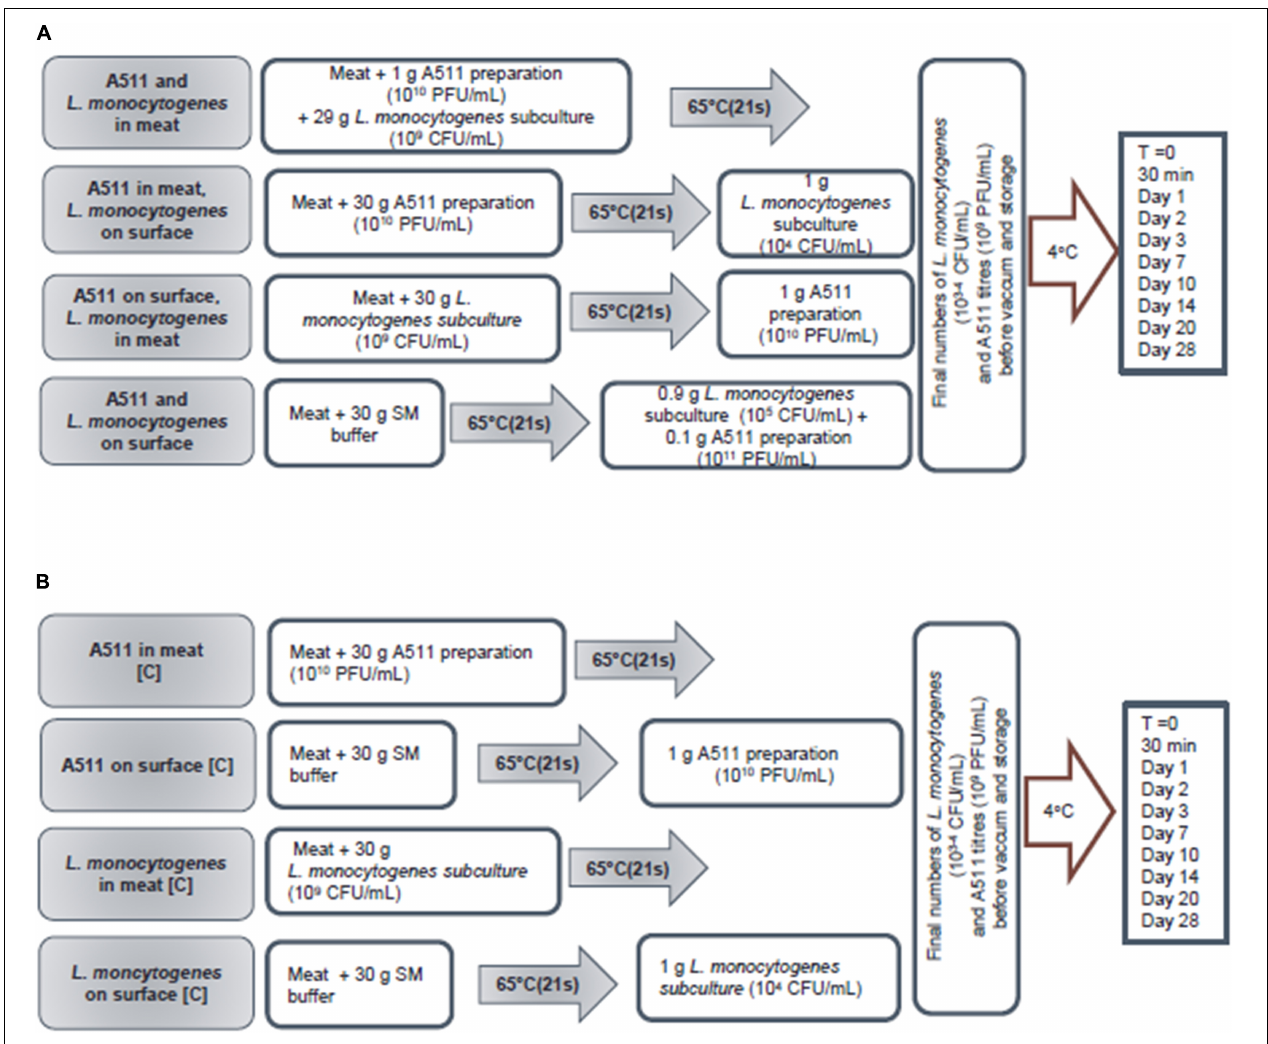
FIGURE 2 | Flow chart showing work flow, sample preparation, inoculation, storage, and sampling plan of treatment (A) and control (B)